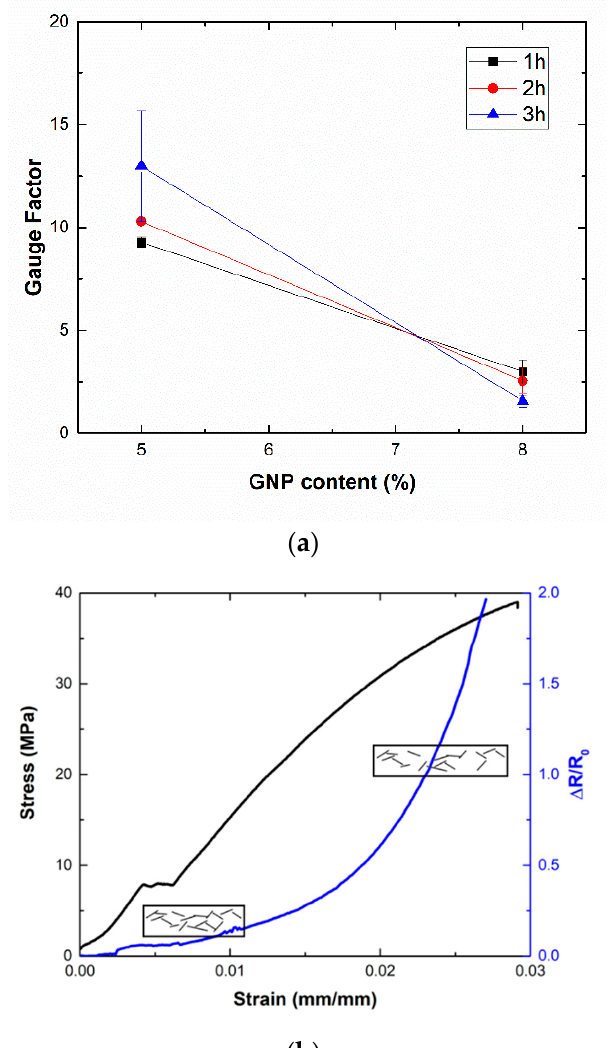
Figure 5. Electromechanic response of GNP nanocomposites showing ( a ) the measured GF and ( b ) an example of a strain-sensing curve.